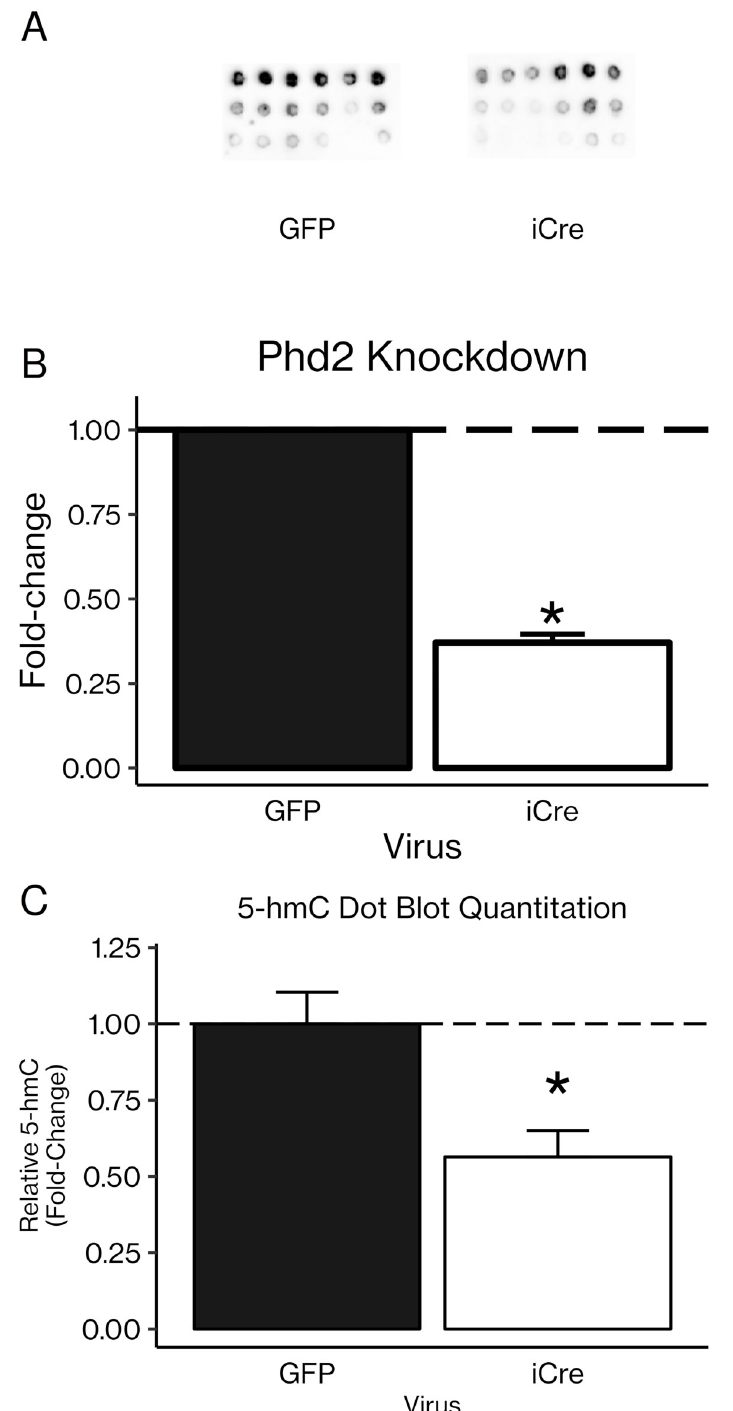
Fig 9. Knockdown of PHD2 significantly reduced 5-hmC levels in primary rib chondrocytes. (A) Primary rib chondrocytes from Phd2 -floxed mice were transduced with an adenoviral vector carrying iCre or GFP as a control. DNA was extracted and dot blotted as in Fig 7. (B) Phd2 gene expression after Phd2 -floxed cells were transduced with adenoviral iCre. � P < 0.01 vs. adenoviral GFP (Student’s t -test), n = 3 per group. (C) Dot blots were quantitated with ImageJ. NB: The images shown in (A) are several exposures stacked to make differences more visible to the eye, while the quantitations in (C) were performed on single, non-stacked images. Results are presented as mean fold-change ± SEM. � P < 0.05 (Student’s t -test), n = 6 per group.